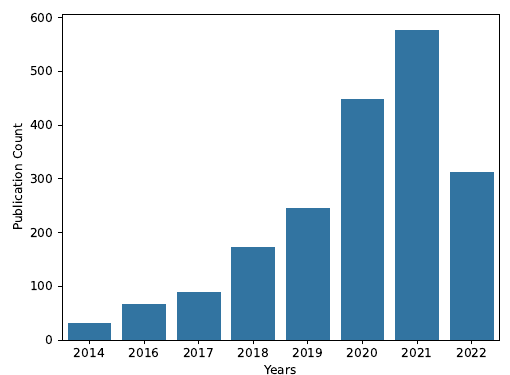
Figure 1. Illustration of the number of publications per year in the context of time series forecasting and deep learning, extracted on 22 June, 2022, on “Web of Science” [4] using the query described in Section 3. Unlike in the field of time series analysis, the fields of CV and NLP have a number of different benchmark datasets that are frequently used to develop new models and compare cutting-edge developments with prior state-of-the-art models. Therefore, it is common practice for these advancements to be evaluated against these benchmark datasets. Two of the most prominent and widely-used datasets in CV are the MNIST [5] and ImageNet [6] datasets for training small and large models, respectively. Specifically, the ImageNet dataset has been frequently used to pre-train large state-of-the-art models that are used for transfer learning, utilizing the pre-trained features for new tasks and individual datasets. Exploiting the pre-trained features allows researchers to achieve state-of-the-art performances even on small datasets after fine-tuning the pre-trained networks. Consequentially, benchmark datasets played an essential role in the advancements of these